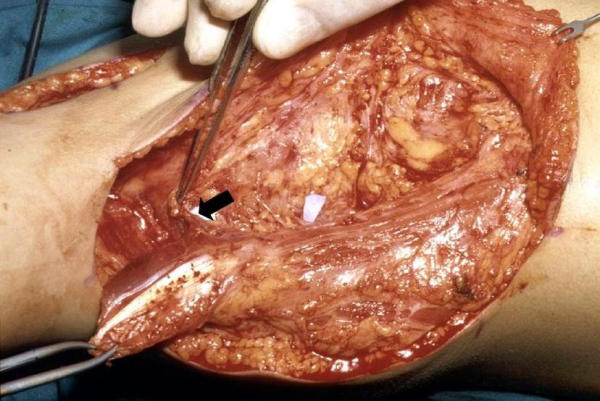
Conjoined tendon preperation. The conjoined tendon is ready for the transfer and its pedicle is pointed medial side of the muscles. Arrow indicates muscle pedicle.